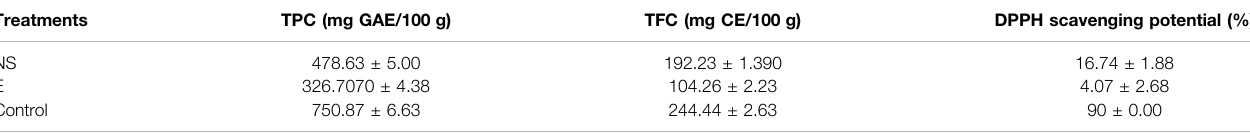
TABLE 1 | Comparison of antioxidant potential of nanosuspension of N. sativa with control. Treatments